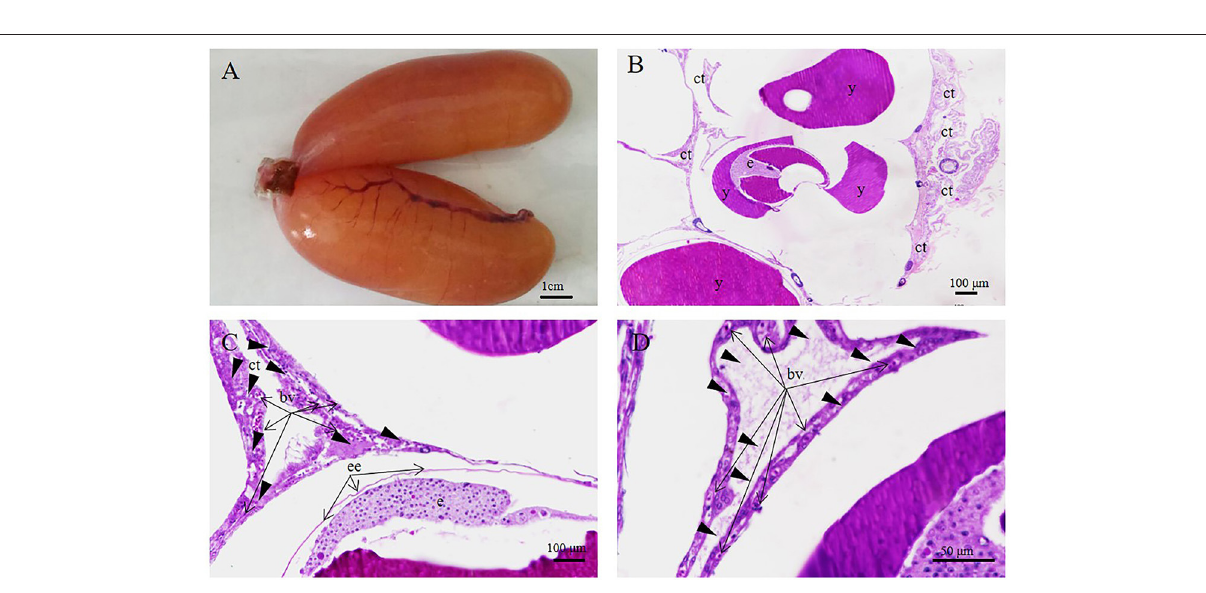
Frontiers in Marine Science |